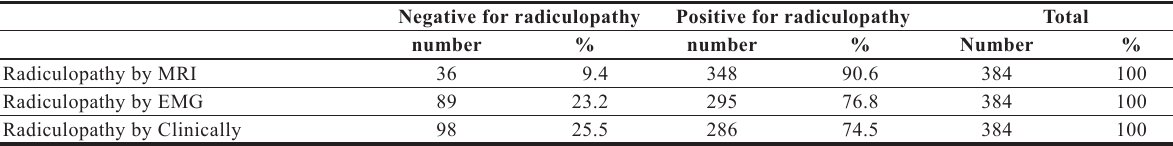
Table 1. Percentage of diagnostic cases using MRI, EMG and clinical examination.